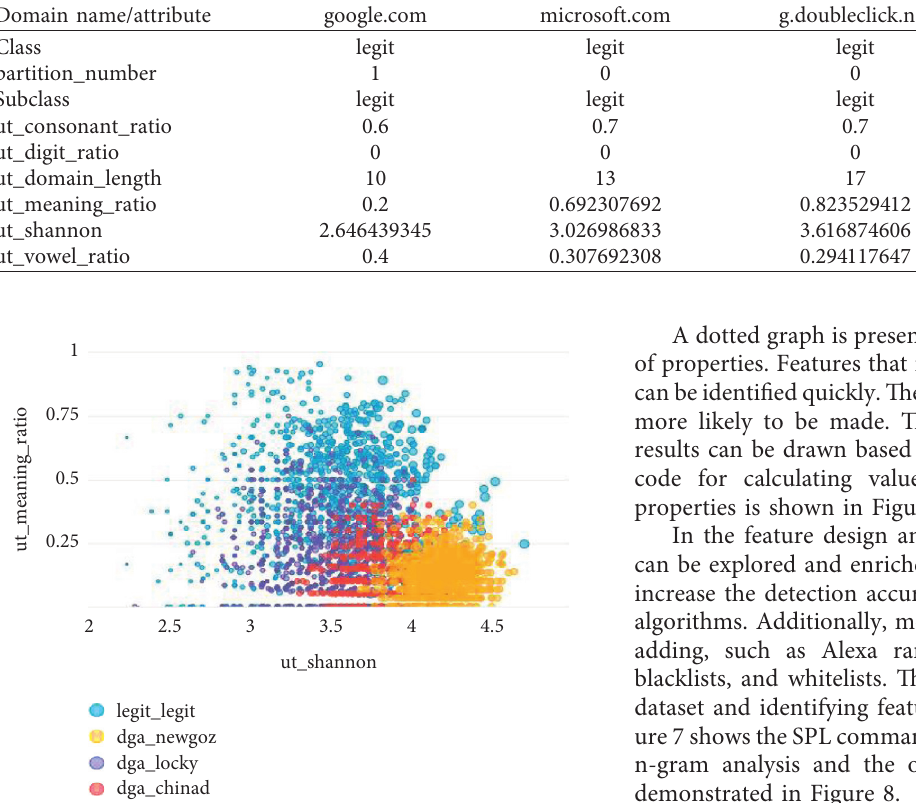
Figure 5: Distribution diagram based on Shannon algorithm and semantic